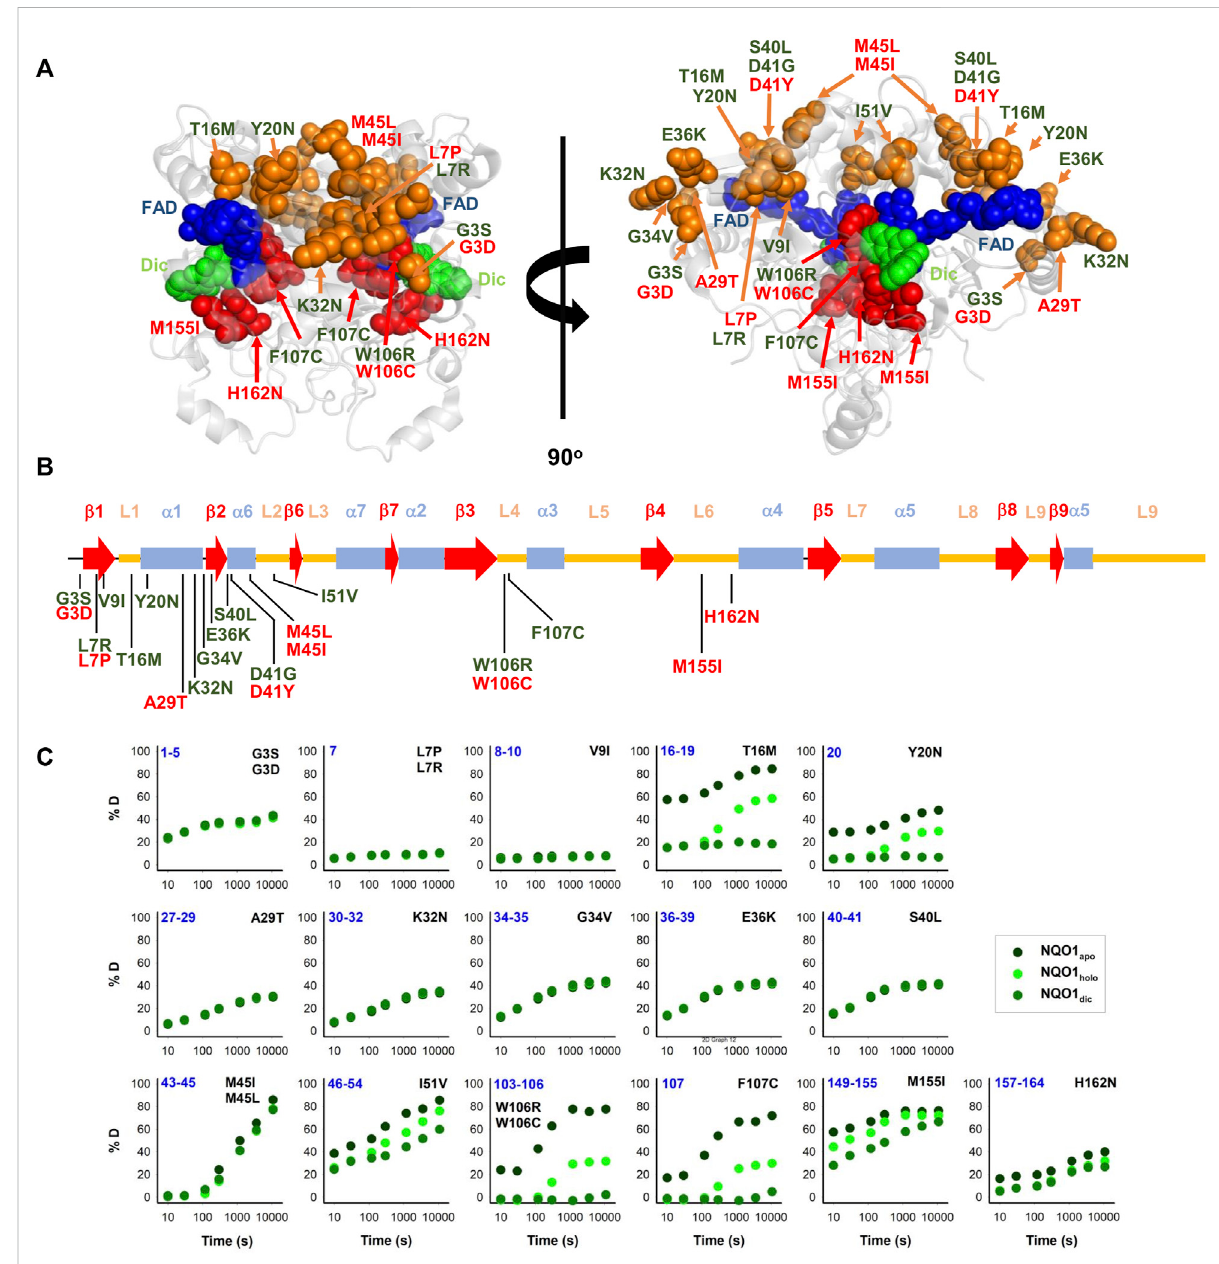
FIGURE 2 Structural features and local stability of the substituted residues and the variants characterized experimentally in this work. (A) The residues mutated were mapped onto the structure of NQO1 (PDB code 2F1O) (Asher et al., 2006). Residues are depicted as spheres, and the colour code indicates substitutions located in the 1 – 51 region (orange) or the active site (red). Variants were labelled in red (from COSMIC) or in green (from gnomAD). FAD and Dic are shown as dot representations in cyan and blue, respectively. (B) Location of substitutions in the sequence of NQO1 regarding secondary structure elements (from (Faig et al., 2000)). Substitutions were labelled in red (from COSMIC) or in green (from gnomAD). (C) HDX of segments containing the 22 variants experimentally investigated in this work. The segments are labelled in blue. The